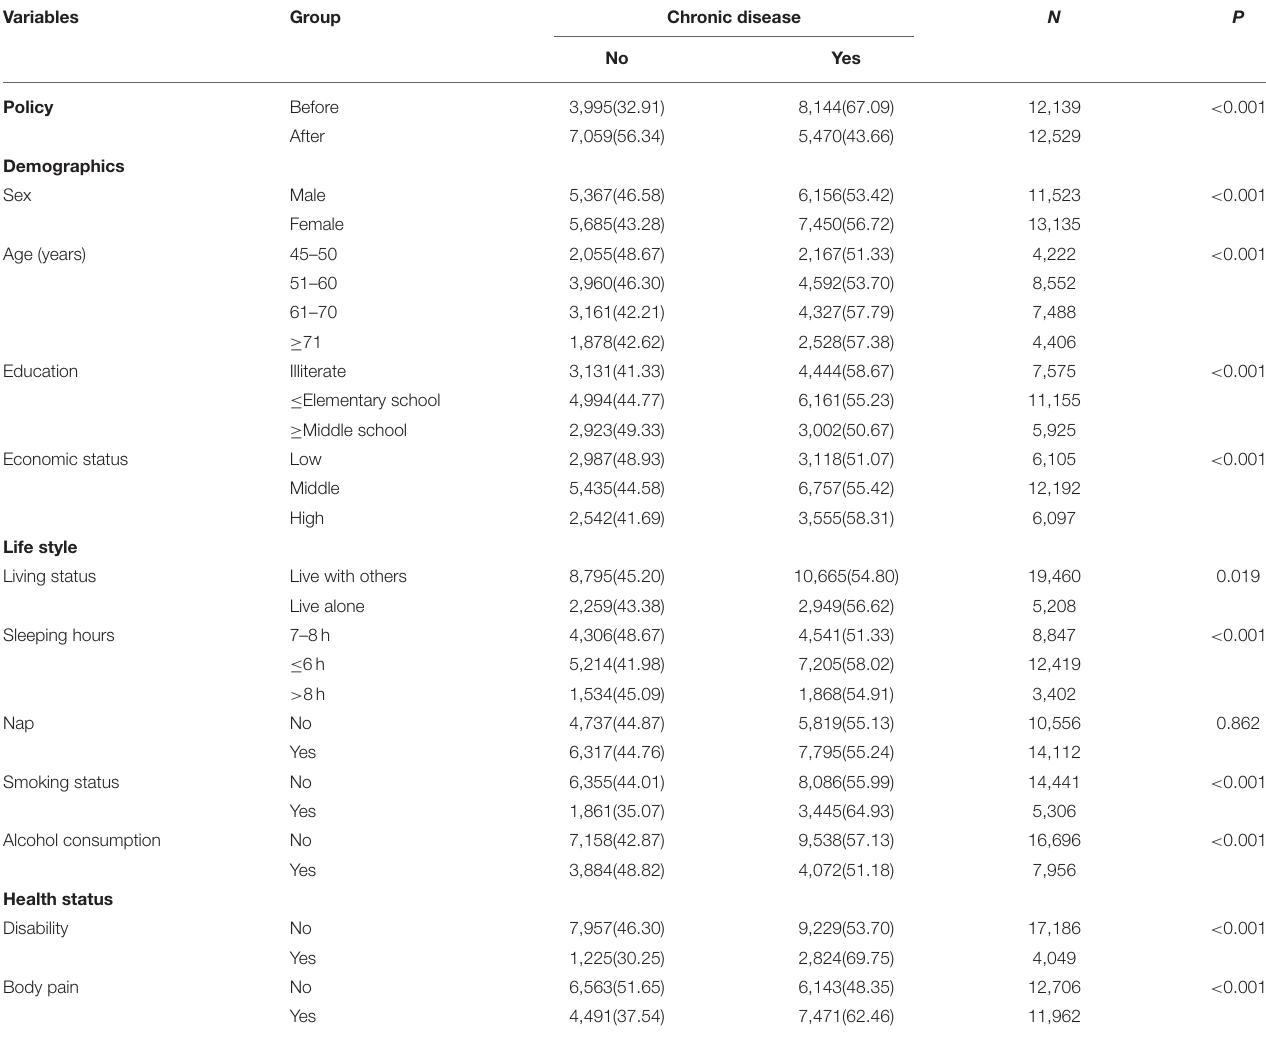
TABLE 3 | Distribution of chronic disease rate among rural participants ( n = 24,668). Variables